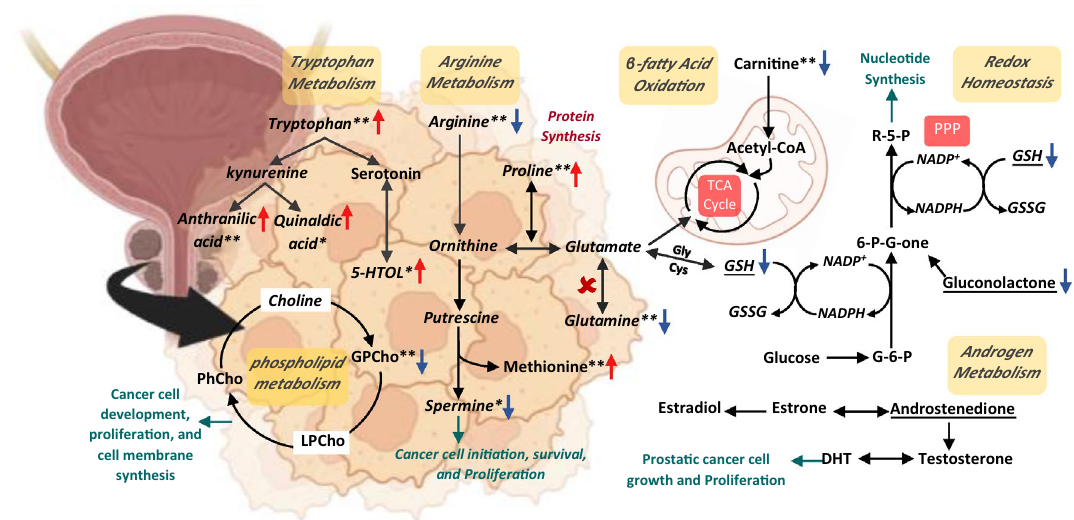
Figure 8. A scheme representation of the different intermediates affected pathways in DU145 cells after treatment with C5 and C6. PPP: pentose phosphate pathway, GSH: glutathione, GSSG: oxidized glutathione, DHT: dihydrotestosterone, G-6-P: Glucose 6-phosphate, 6-P-G-one: 6-phosphogluconate, r-5-P, SAM: S-Adenosyl methionine, 5-HTOL: 5-hydroxytryptophan, PhCho: phosphatidylcholine, LPCho: lysophosphatidylcholine, and GPCho: Glycerophosphocholine. Red arrows indicate upregulation, while blue arrows indicate down regulation. ** Significant in DU145 cells treated with C5 only, * Significant in DU145 cells treated with C6 only, and underlined metabolite is significant in both C5 and